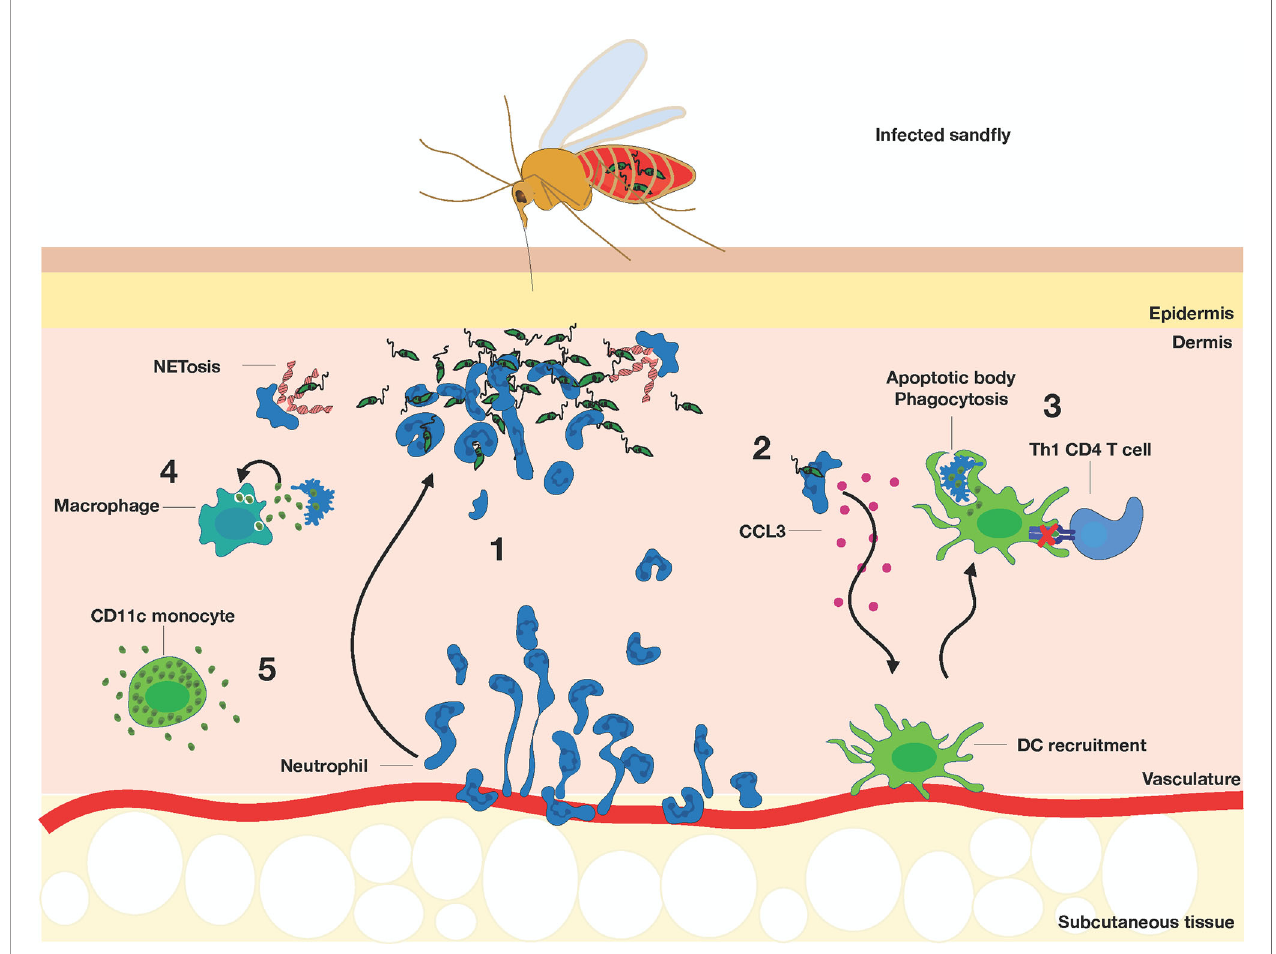
FIGURE 3 | Acute response to Leishmania infection by a sand fl y bite. (1) Neutrophils (dark blue) are recruited from the blood to the site of infection, undergo NETosis, and phagocytose the promastigotes. (2) Infected neutrophils recruit DCs (green) by producing CCL3, which subsequently engulf the apoptotic bodies of infected neutrophils and (3) lose their ability to effectively activate Th1 response (light blue). (4) Macrophages (dark green) become infected by the parasites released by the dying neutrophils. (5) CD11c + monocytes (green) are highly permissive to parasite replication and further promote